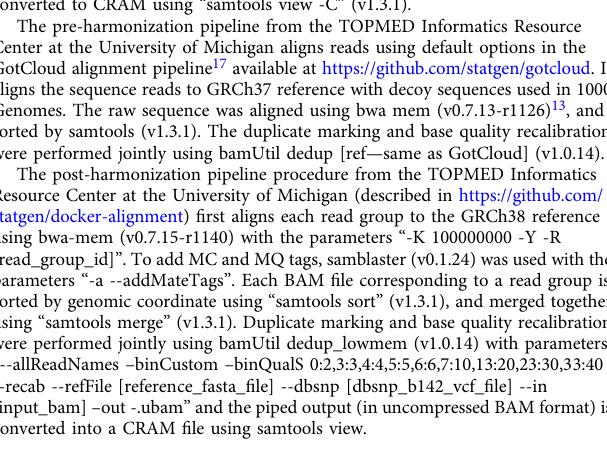
the parameters “ -Y -K 100000000 ‘ . Picard (v2.4.1) FixMateInformation is run with the parameter ‘ FixMateInformation = TRUE ” . Read group BAM fi les are merged